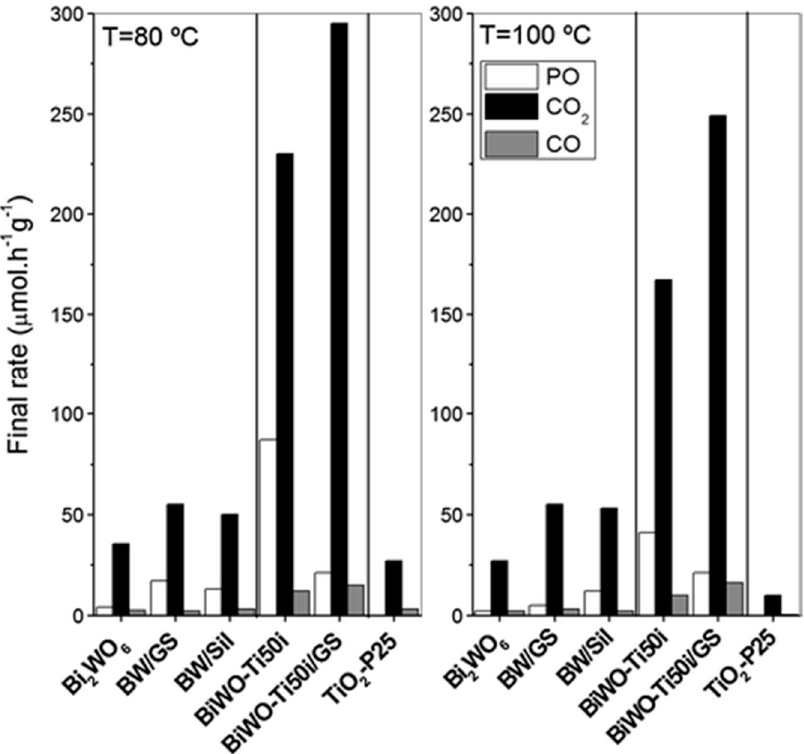
Figure 4. Formation rate of PO, CO 2 , and CO obtained with different catalysts during photo-epoxidation at 80 ˚ C and 100 ˚ C. Reproduced with permission from [16] .